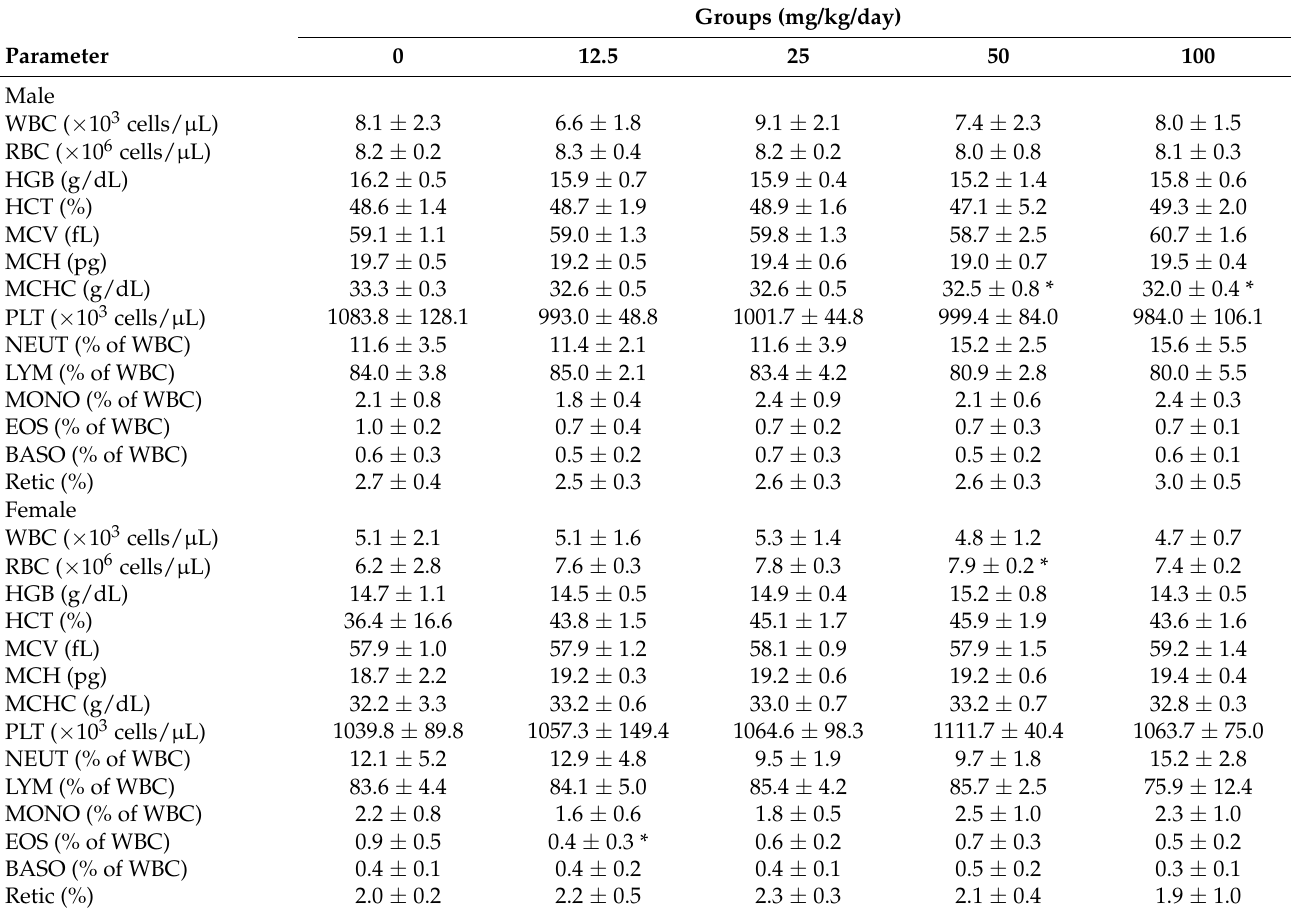
Table 6. Hematological parameters after the 28-day repeated oral toxicity